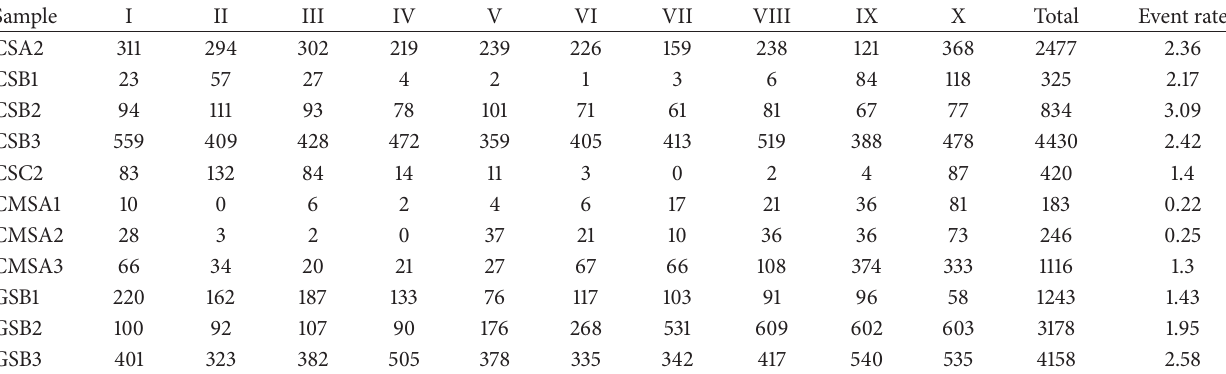
Table 3: MS event count distribution and accumulation in different loading